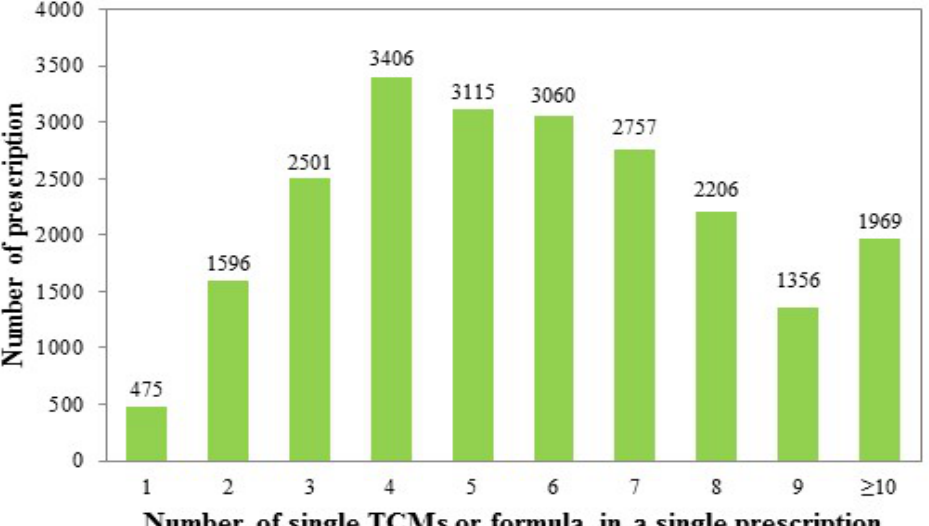
Figure 2. Relationship between the number of prescriptions and the number of TCMs. The average is 5.82 ± 2.77 TCM items in a single prescription for treatment of subjects with IHD (total prescription number, n = 22,441). Table 6. The most common two-drug combinations of TCM in a single prescription for IHD (Total prescription number, n = 22,441).